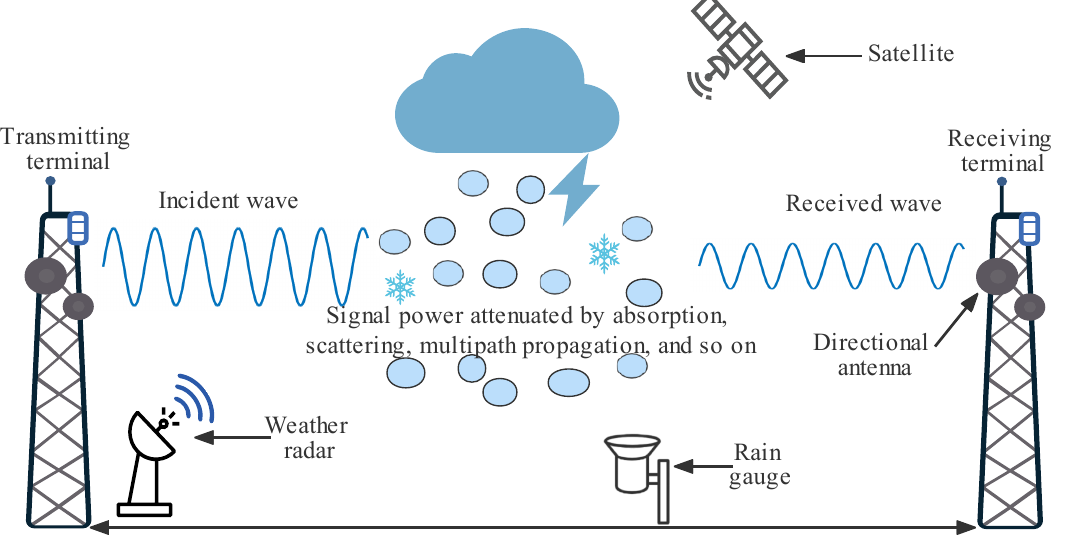
Figure 1. Basic operating principle of CML-based rainfall